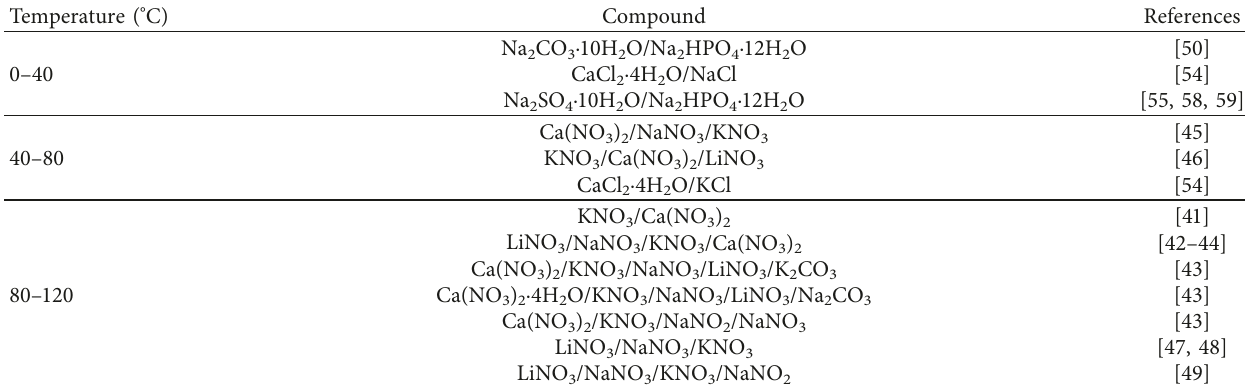
Table 1: The melting point of low-temperature inorganic eutectic composites.